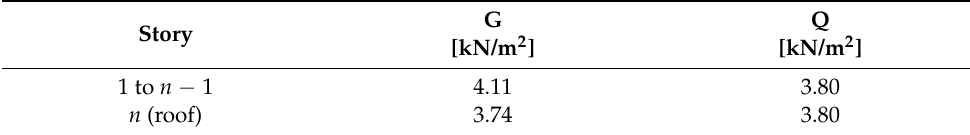
Figure 2. Elevation views of case-study structures (dimensions in m).